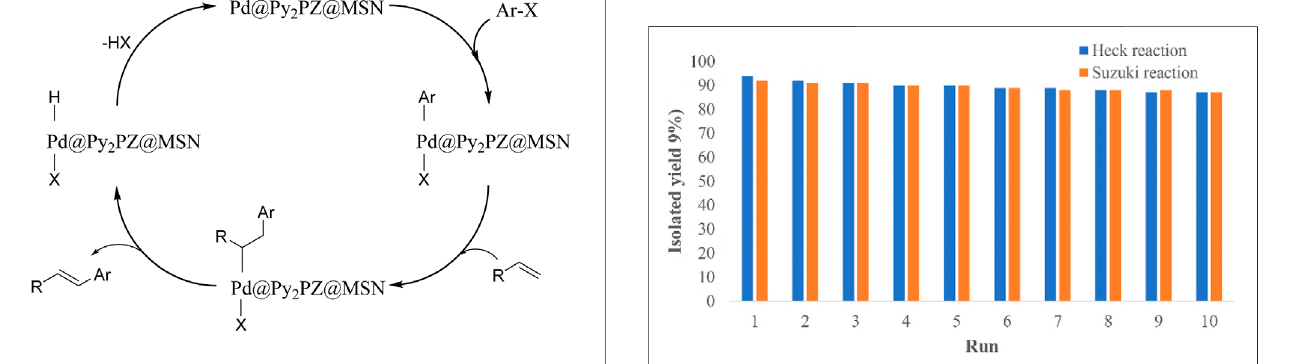
FIGURE 3 | Recovery results of the Pd@Py 2 PZ@MSN